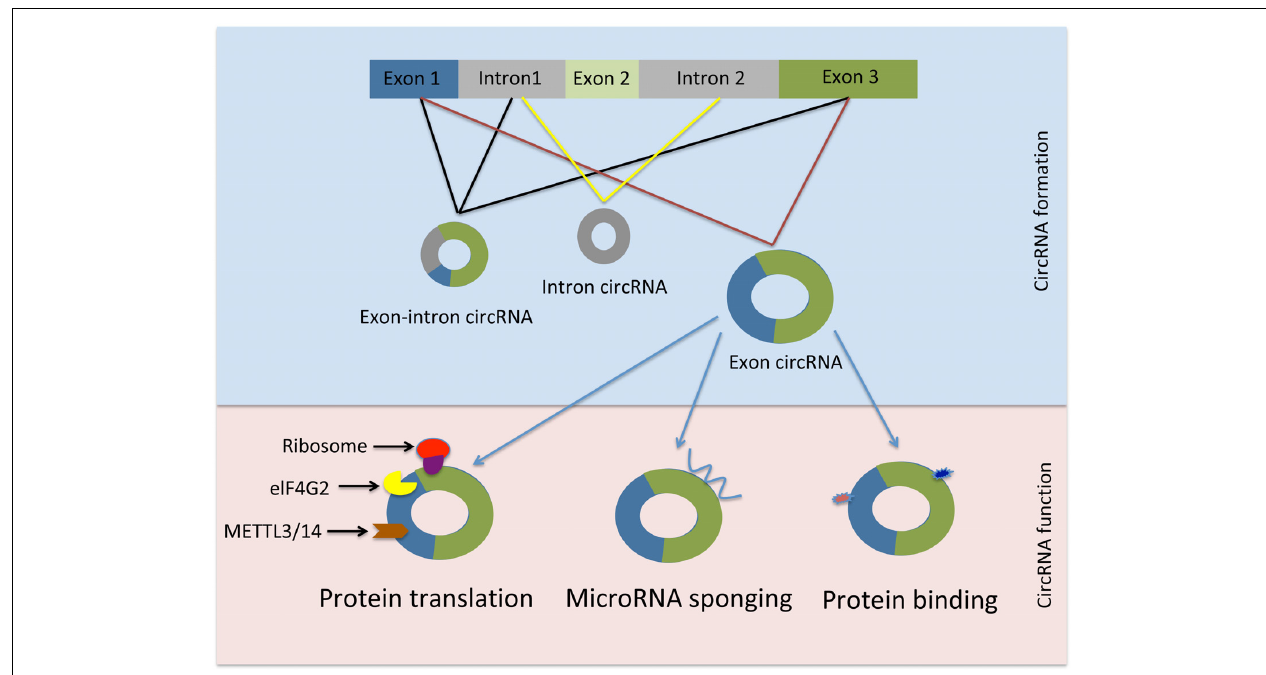
FIGURE 1 | Schematic representation of circRNAs generation and function. elF4G2, initiation factor eukaryotic translation initiation factor 4 gamma; METTL3, methyltransferase-like 3; METTL14, methyltransferase-like 14.